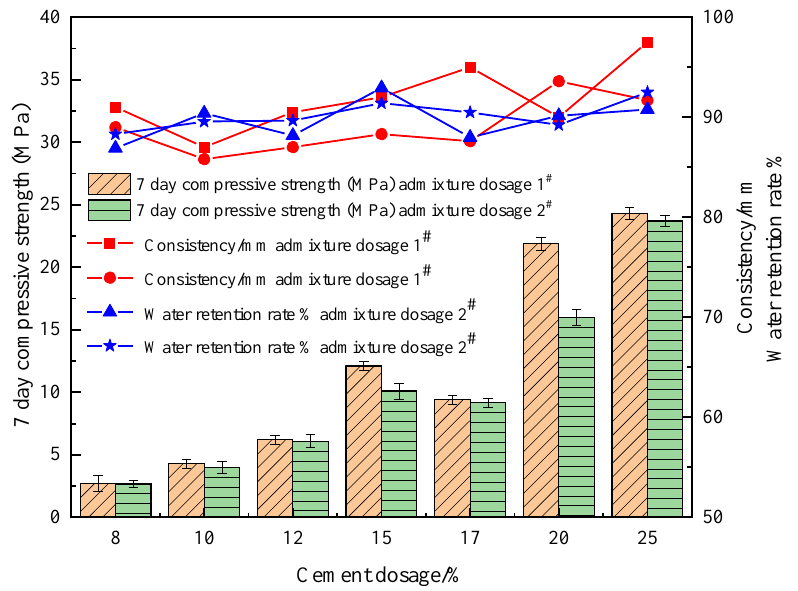
Figure 5. Influence of cement content on dry-mixed mortar.